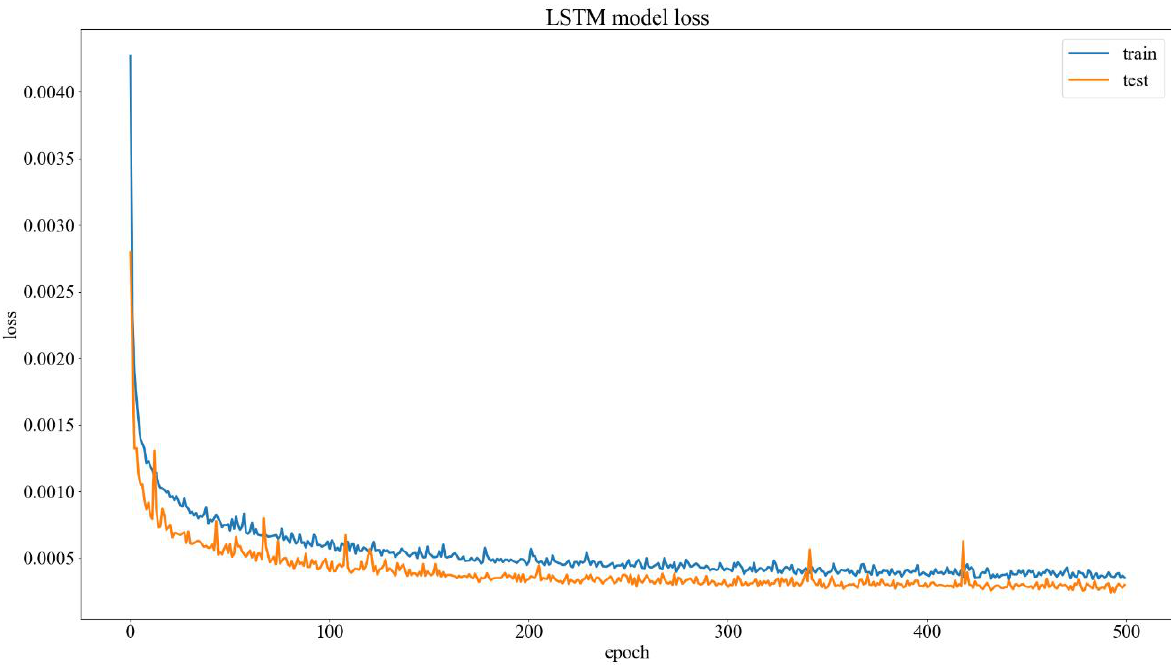
Figure 12. Model train loss vs. validation loss for many velocity commands for different trajectories.